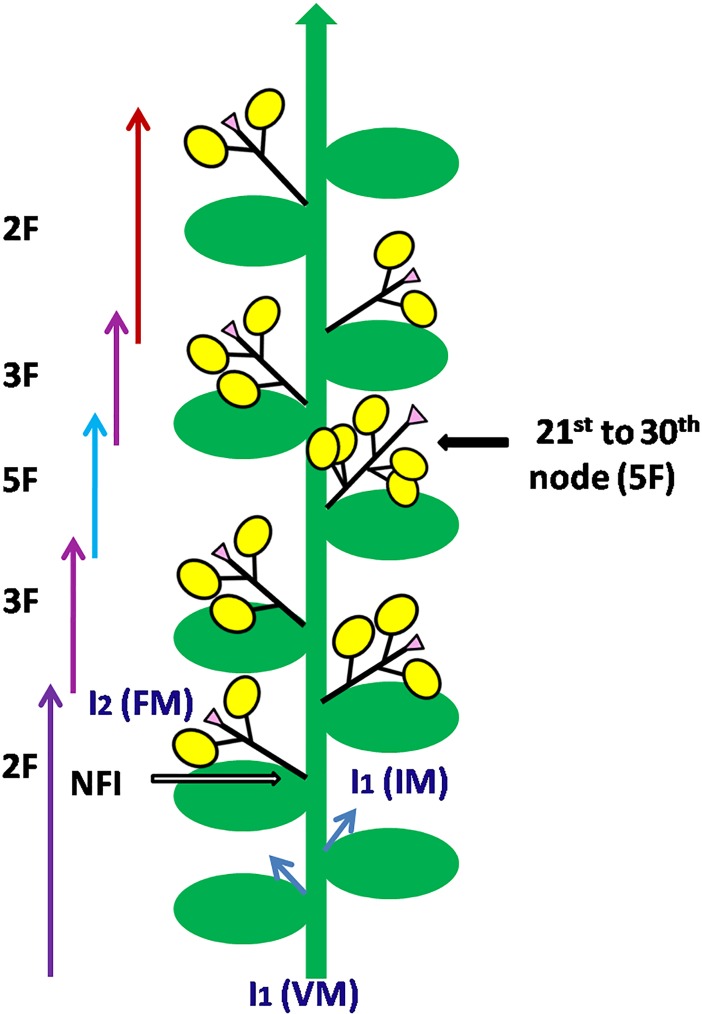
Pictorial presentation of a compound raceme of the garden pea, resulting in two, three and five flowers per peduncle at specific nodes.Green arrows indicate indeterminate growth of the inflorescence stem (I; I1); Green ovals represent leaves; Yellow circles represent flowers; Pink triangles are stubs terminating at each secondary inflorescence (I2) axis; VM: Vegetative meristem; IM: Inflorescence meristem; I1M: Primary inflorescence meristem; I2M: Secondary inflorescence meristem; FM: Floral meristem; NFI: First node of flower initiation.